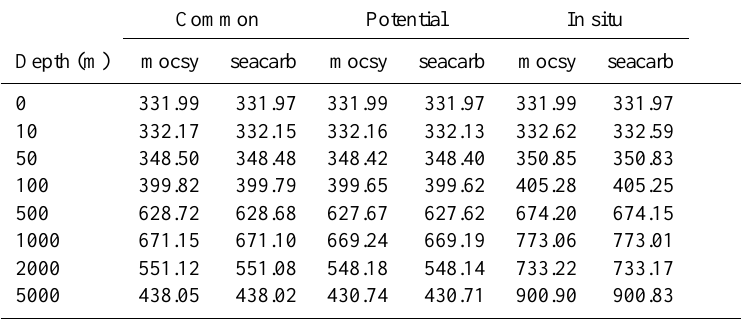
Table 9. Oceanic f CO 2a from three approaches b in two packages. Common Potential